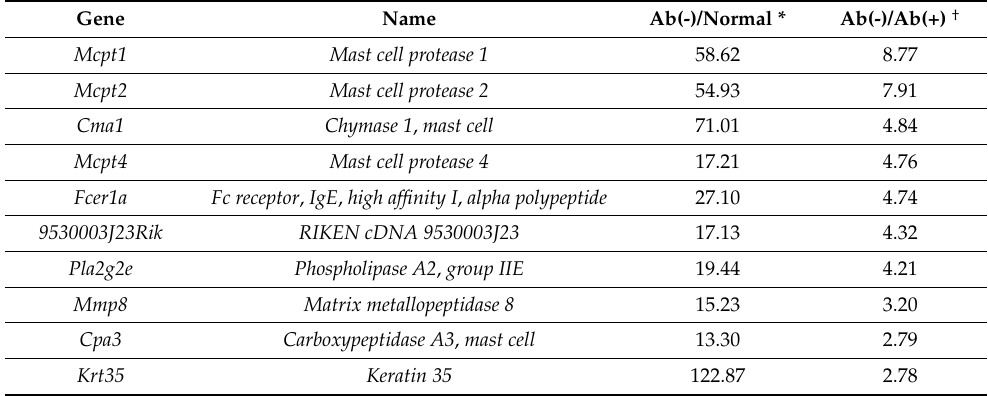
Table 2. Microarray results of top 10 downregulated genes in cancerous tissues from AOM/DSS mice with and without anti TNF- α Ab.